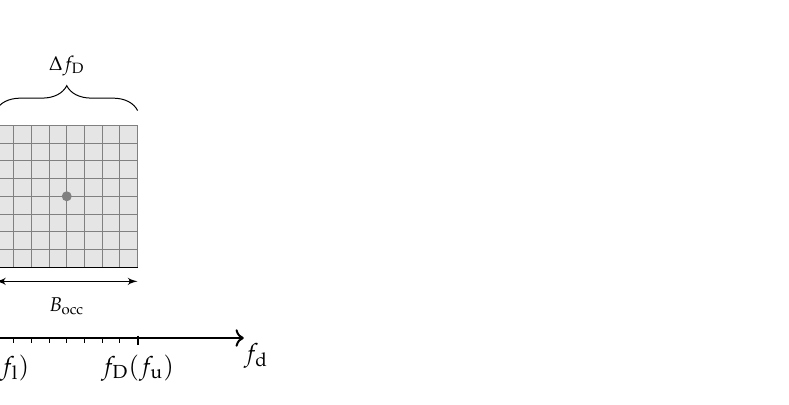
Figure 7. Constantly moving point scatterer extended uniformly in range-Doppler ( B eff ≈ B occ